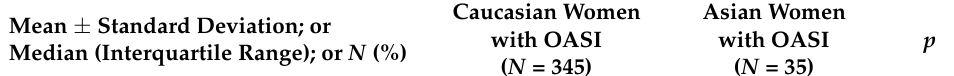
Table 1. Maternal and neonatal characteristics of Caucasian women versus women of Asian ethnicity who endured